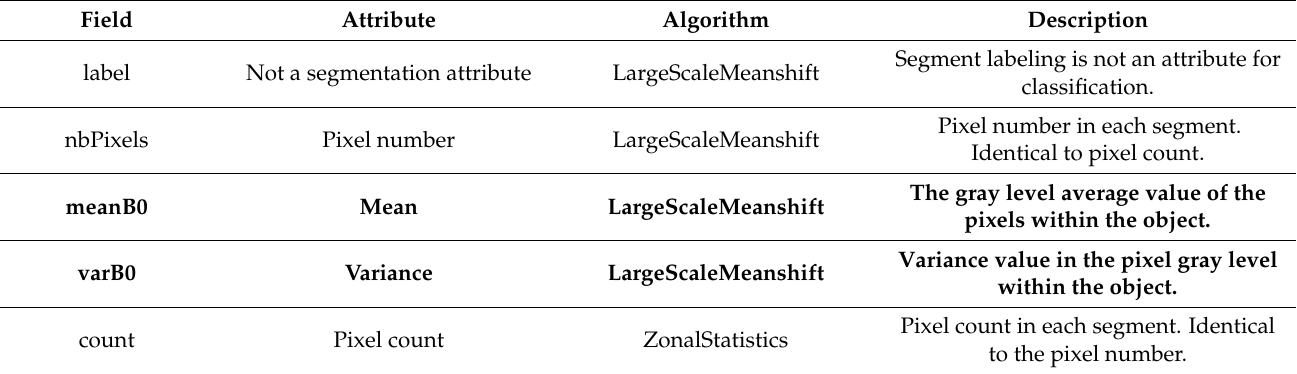
Table A1. Attributes calculated by the LargeScaleMeanshift and ZonalStatistics algorithms of the OTB package implemented in QGIS. Those highlighted in bold were calculated for each raster band used in the process. As an example, only the statistics of band 0 (B0) are shown. Attribute Algorithm Description